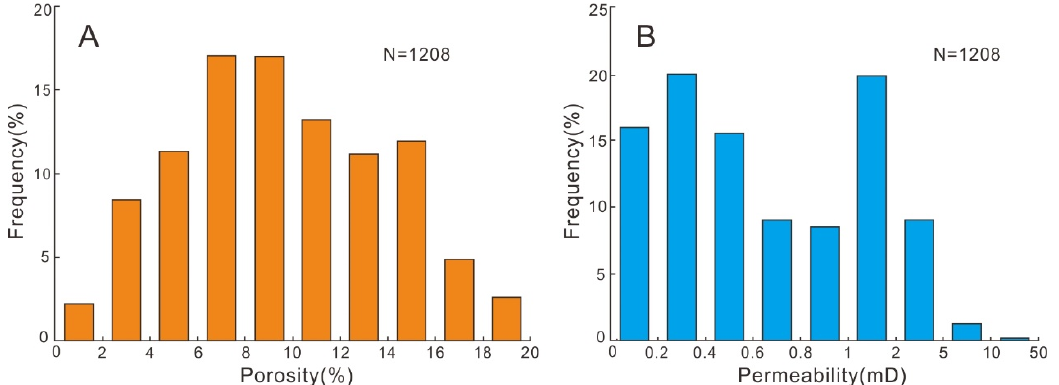
Figure 3. Histogram of the porosity ( A ) and permeability ( B ) of the sandstone in the Lower Shihezi Fm., Hangjinqi area. Fm., Hangjinqi